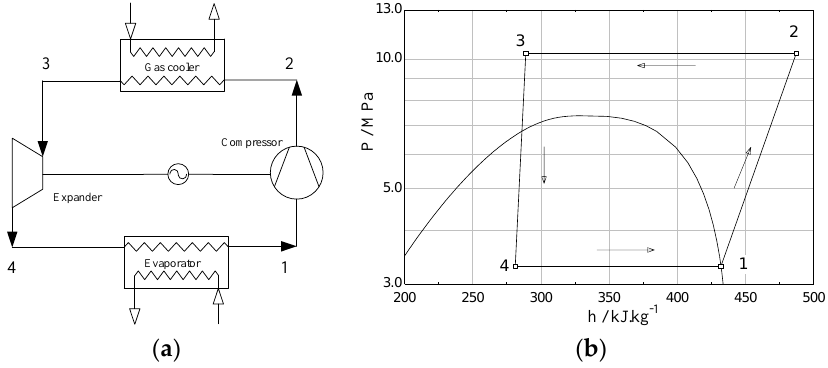
Figure 1. Schematic of SE cycle and the corresponding P-h diagram. ( a ) Schematic diagram; ( b ) P-h diagram.